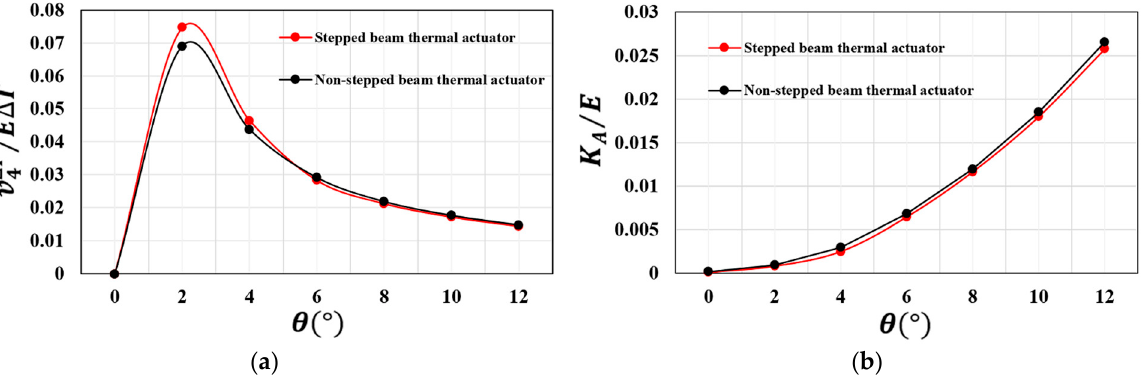
Figure 5. ( a ) Displacement as a function of the inclined beam angle; ( b ) stiffness as a function of the inclined beam angle.